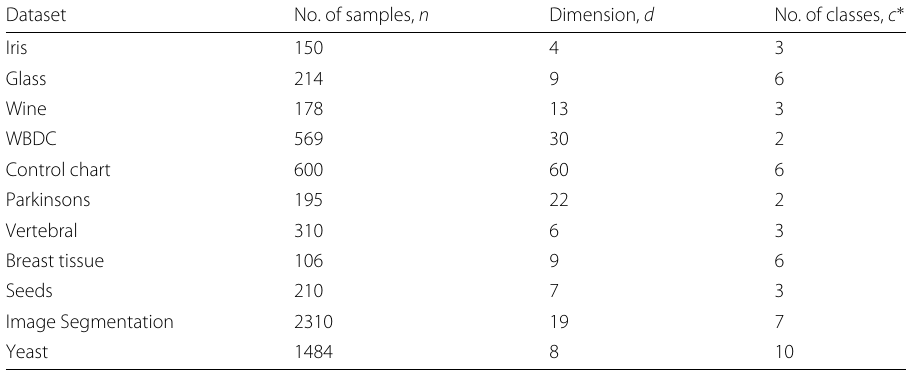
Table 1 Attributes of the eleven real datasets from the UCI repository used in this study Dataset No. of samples, n Dimension, d No. of classes, c ∗